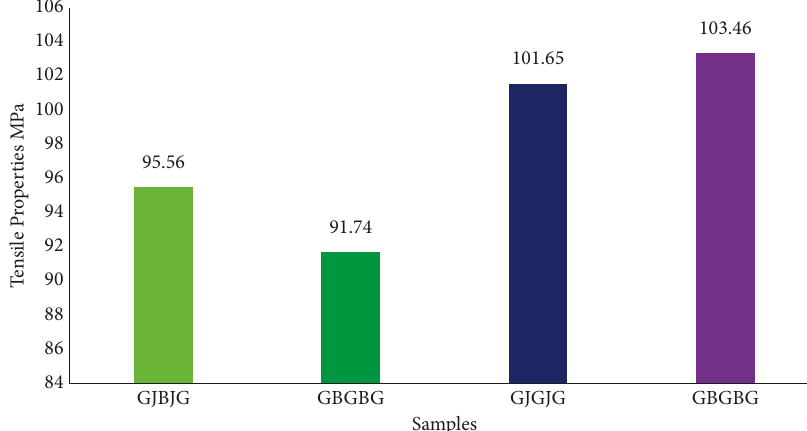
Figure 4: The composites’ tensile strength.